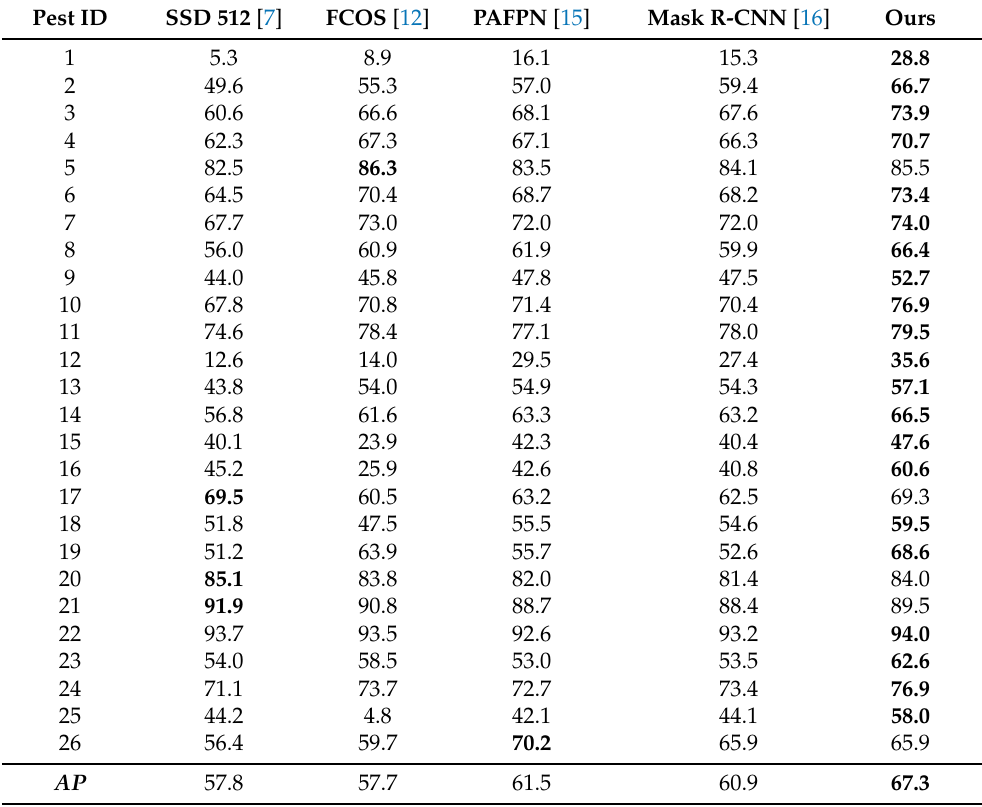
Table 3. AP 50 of all pest categories with different detection methods (unit: % ). Pest